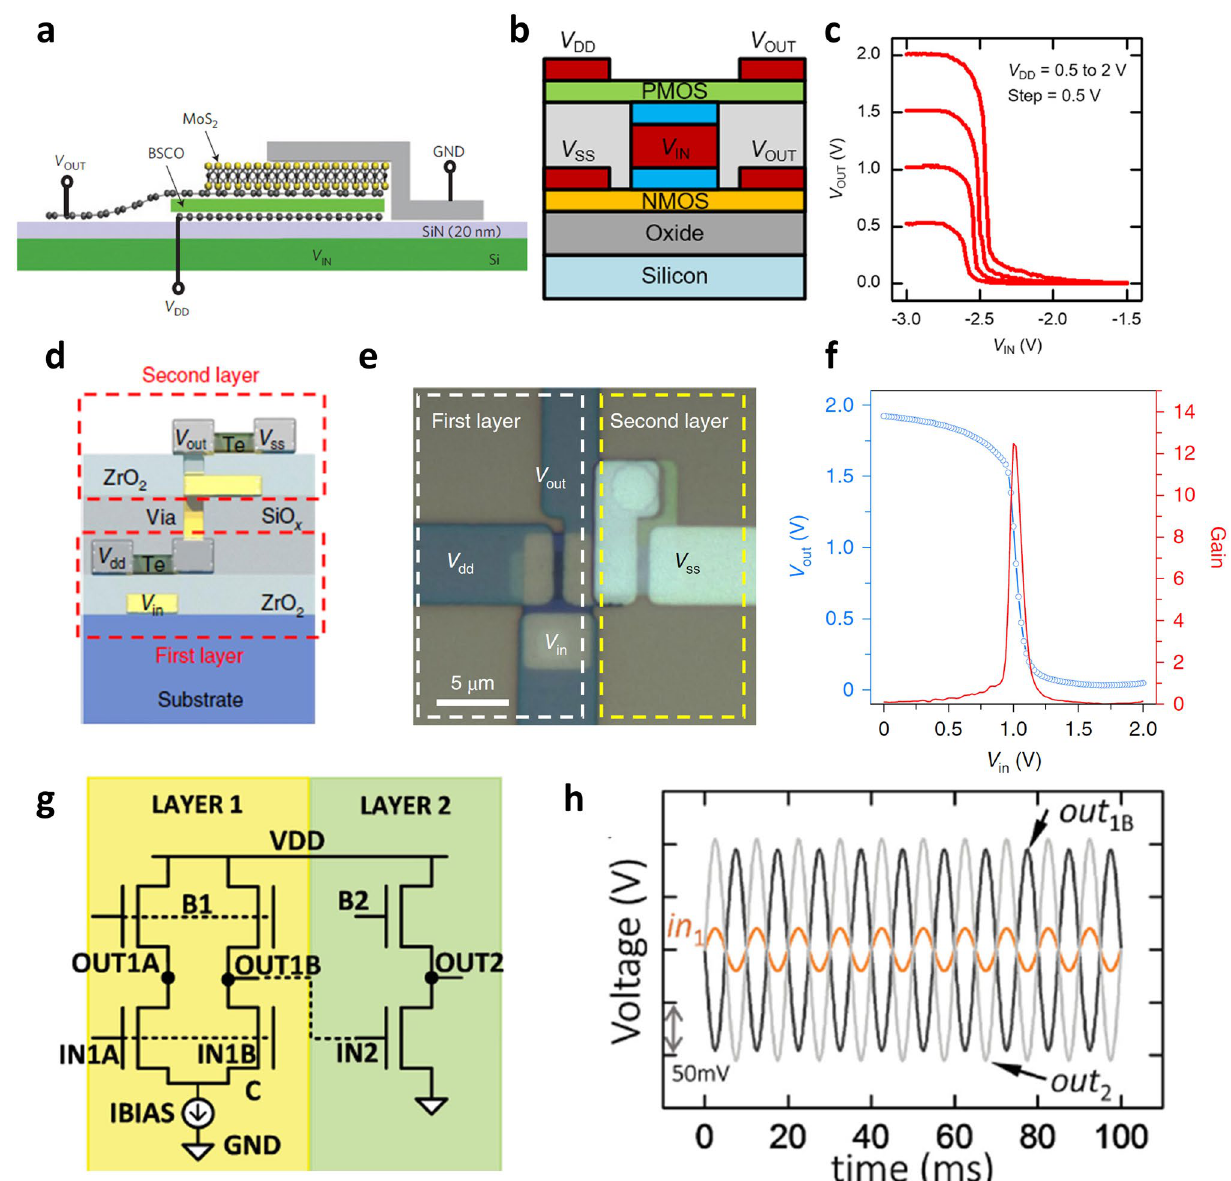
Fig. 8 a Illustration of a vertically stacked inverter based on vertical transistors composed of MoS 2 and Bi 2 Sr 2 Co 2 O 8 [97]. Copyright © 2013, Springer Nature. b A schematic diagram of a vertically stacked inverter with a structure in which n-type MOS 2 TFT and p-type WSe 2 TFT share a gate. c Voltage transfer characteristics of the vertically stacked inverter [12]. Copyright © 2017, AIP Publishing. d, e Schematic and optical microscopy images of the thermal deposited Te TFT-based vertically stacked inverter structures. f Voltage transfer characteristics of Te-based vertically stacked inverter [32]. Copyright © 2020, Springer Nature. g Circuit diagram of differential amplifier (bottom layer) and common source amplifier (top layer) designed using MoS 2 and WSe 2 . h Output of differential amplifier (bottom layer) and common source amplifier (top layer) circuit for an input signal with a peak-to-peak voltage of 50 mV [98]. Copyright © 2016, John Wiley and